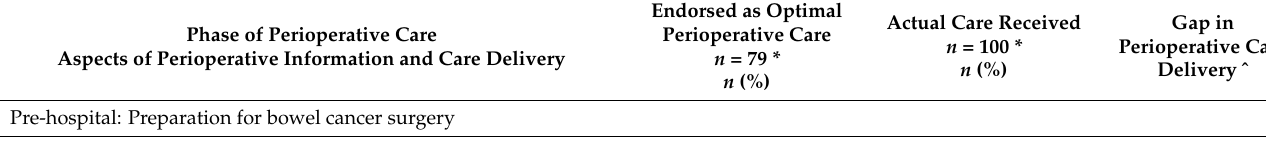
Table 3. Aspects of perioperative information and care endorsed as ‘optimal’ by 80% or more of patients: perceptions of optimal care versus experiences of actual care